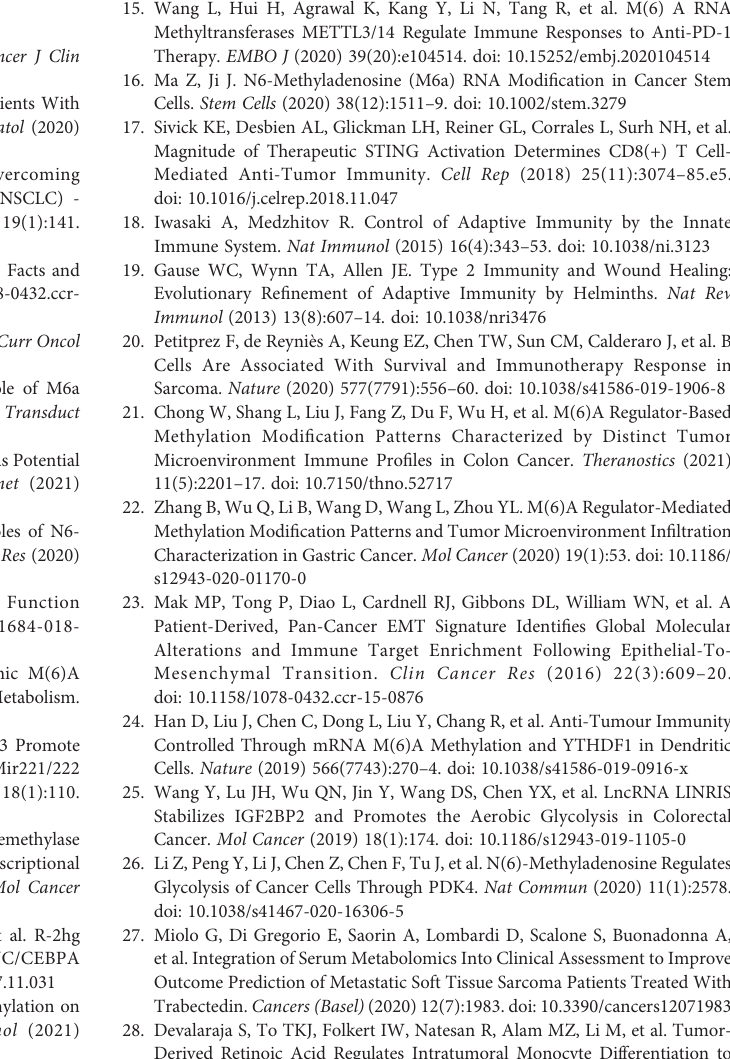
Supplementary Table S1 | The numbers of samples and the clinical baseline and endpoint data of each STS sample in TCGA-SARC and GSE21050 cohorts. Supplementary Table S2 | Prognosis-relatedmetabolicpathwaysselectedby univariateCoxanalysis,multivariateCoxanalysisandtherandomSurvivalForestalgorithm. Supplementary Table S3 | 2183 DEGs (|log 2 FC|>0.5 and FDR<0.05) by comparing the two m6A modi fi cation patterns. Supplementary Table S4 | 579 immune phenotype (ImmuneScore)-related genes, 326 metabolism phenotype-related (retinoic acid metabolism) genes, and 286 stemness phenotype (mRNAsi)-related genes. Supplementary Table S5 | The results of univariate and multivariate Cox analysis for 531 CpG sites in the 21 m6A regulator genes. Supplementary Table S6 | 204 DEGs (log 2 FC>1 and FDR<0.05) by comparing the two m6A modi fi cation